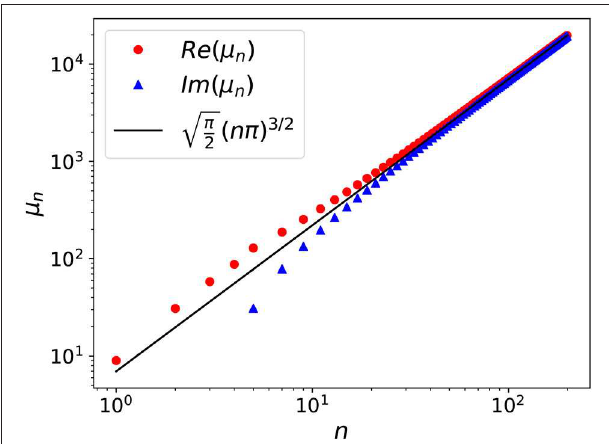
FIGURE 10 | The real and imaginary part of the alternate eigenvalues for the matrix L v in Equation (70). The first 4 eigenvalues are completely real and distinct. The higher eigenvalue comes in complex conjugate pairs. For large i ). For smaller n , there is a deviation from asymptotic scaling µ n ( n π ) 3 / 2 (1 ∼ ± due to finite definition of the operator (adapted from Kundu et al. with permission from [34] Copyright (2018) by American Physical